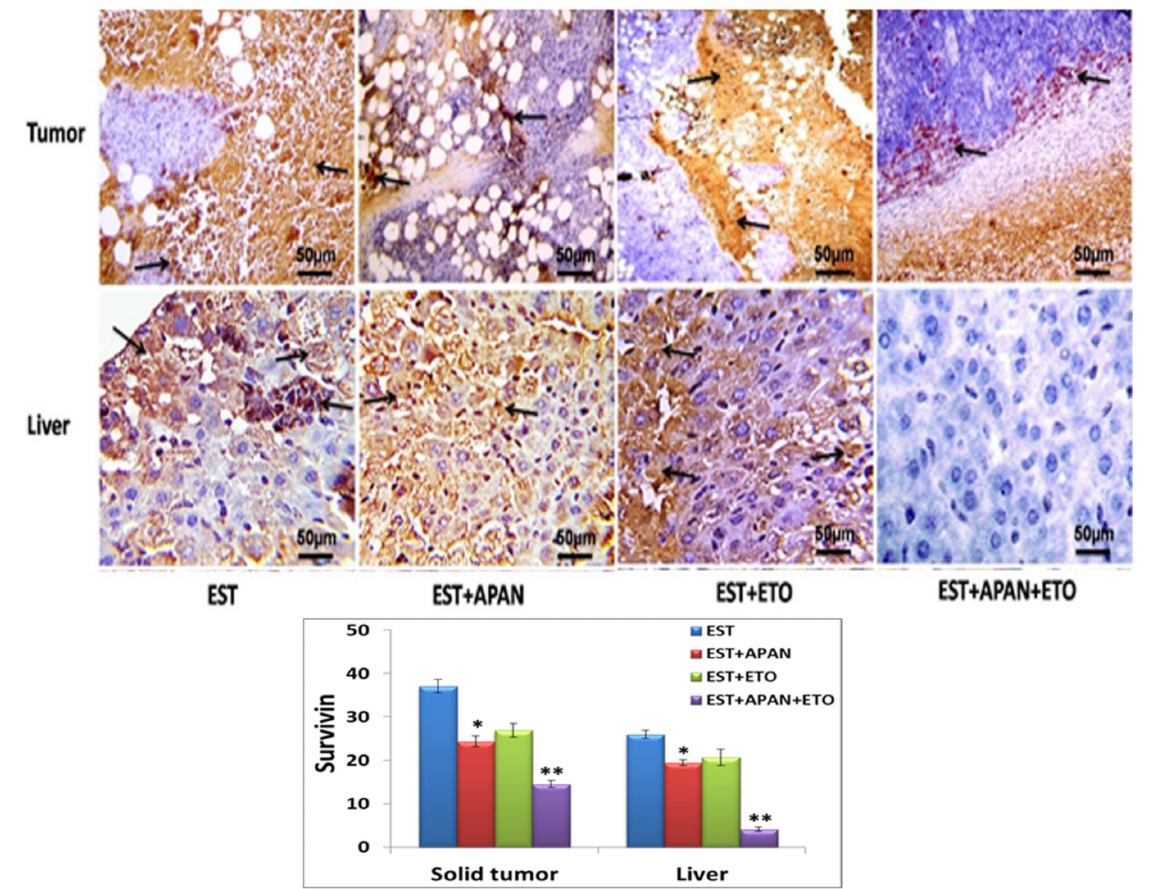
Figure 10. Photomicrographs and chart of survivin immunohistochemical expression (arrows) of Ehrlich solid tumor-bearing mice (EST) after mono (EST+APAN or EST+ETO) and dual treatment (EST+APAN+ETO). Scale bar of solid tumor and liver = 50 µ m, (*) indicates significantly different, (**) indicates the maximum decrease ratio compared to the EST group, p < 0.01.